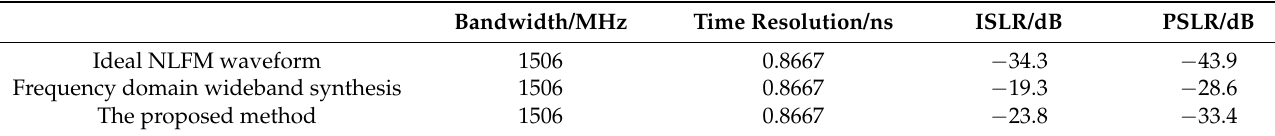
Figure 12. Multisubpulse UWB NLFM waveform synthesis method. Table 3. Performance indicator of range-compressed UWB NLFM SWW.